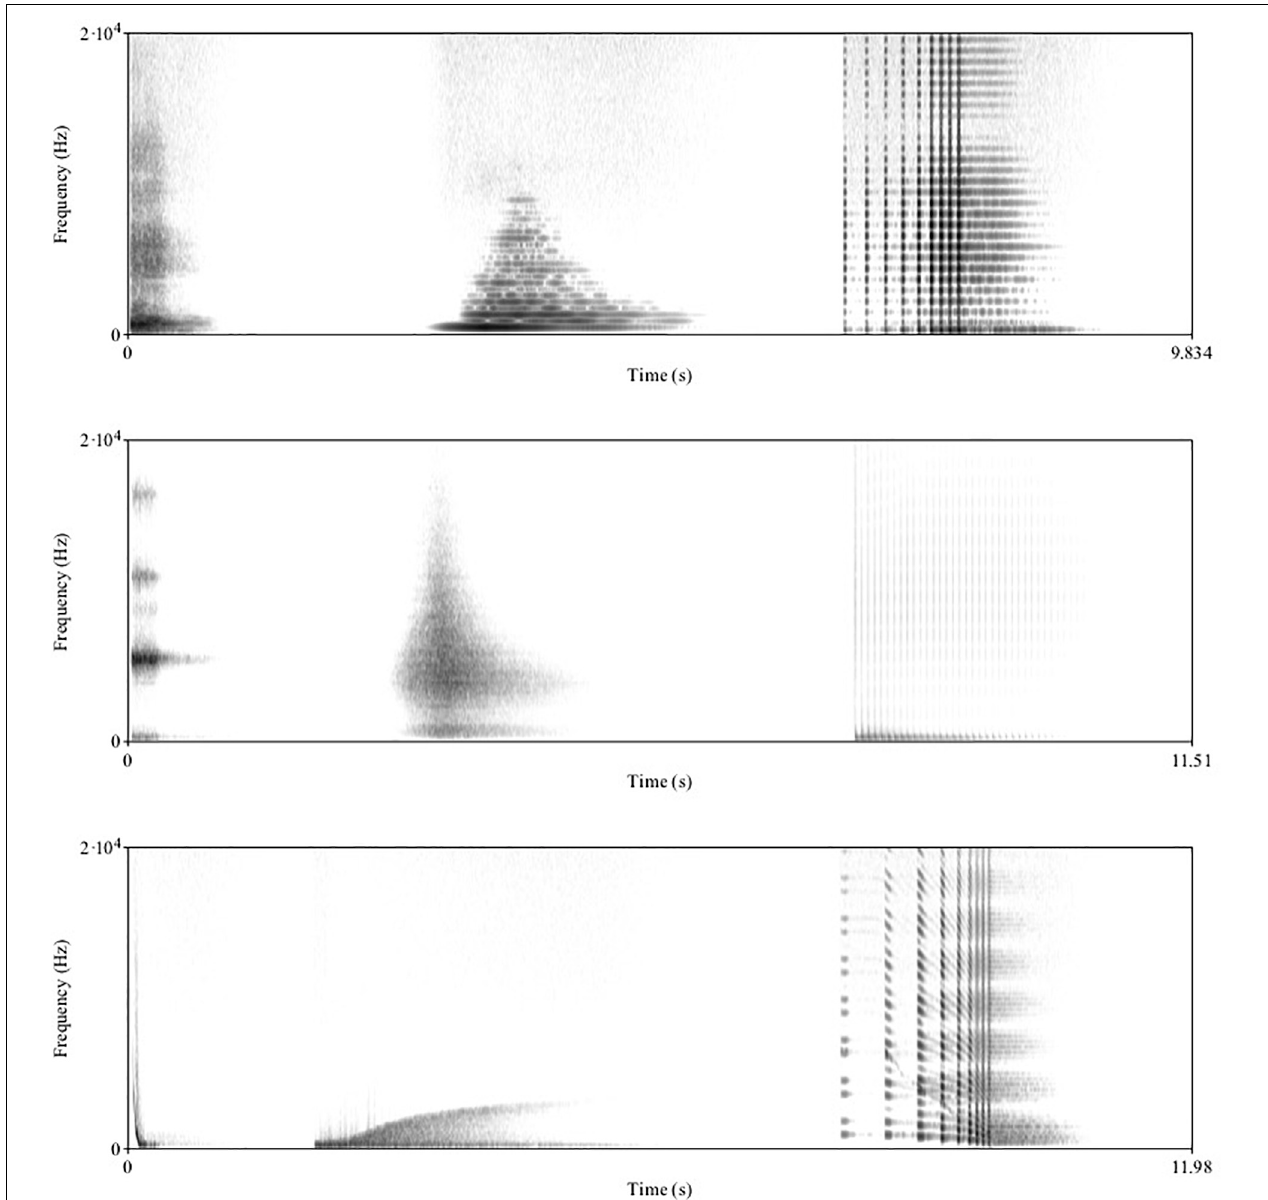
FIGURE 2 | A 3 × 3 typological matrix of spectrograms based on electronic sounds from Solfège CD3, tracks 40, 41, and 42. In the first row, spectrograms of track 40 with tonic mass, i.e., clearly perceivable pitches, in the second row, spectrograms of track 41 with complex mass, i.e. inharmonic and noise-dominated sounds, and in the third row, track 42 spectrograms with varied mass, i.e., glissando pitches. In each row, the envelopes have respectively, an impulsive, a sustained, and an iterative facture (see main text for explanation of “facture”). Notice the overall dynamic envelopes of these different factures, i.e., the abrupt of the impulsive, the prolonged of the sustained, and the punctual and accelerating of the